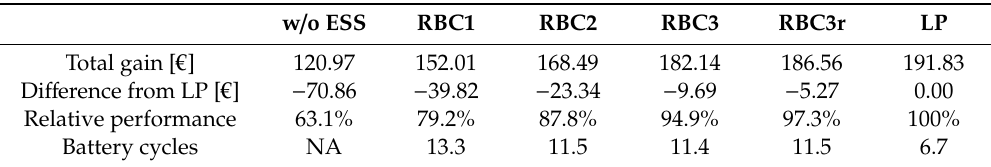
Table 2. Main results: Total gain and battery use.